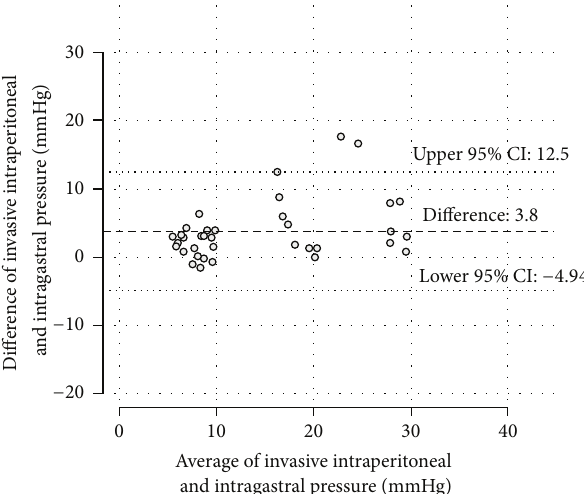
Figure 3: The Bland-Altman diagram plots the differences against the averages of simultaneous IAP measurements from the intra- gastric probes and the invasive piezoresistive probe values. An increasing divergence between the measurement modalities from the 20 mmHg plateau towards the 30 mmHg plateau is indicated.